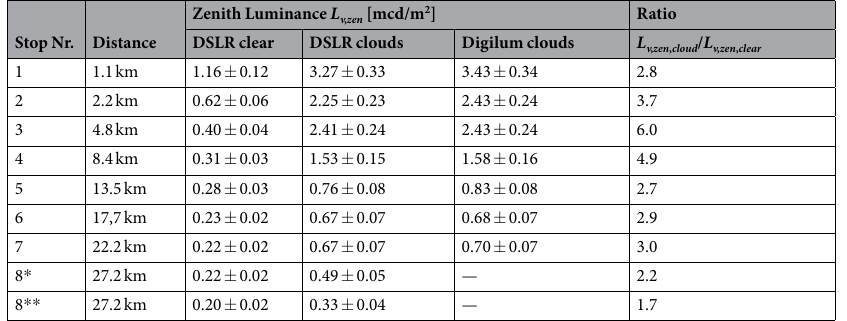
Table 1. List of the zenith luminance values at the different locations and the two nights (see methods for details). Please note that the values for the last measurement site show data from earlier in the night (8 * ) and later in the night (8 ** ).